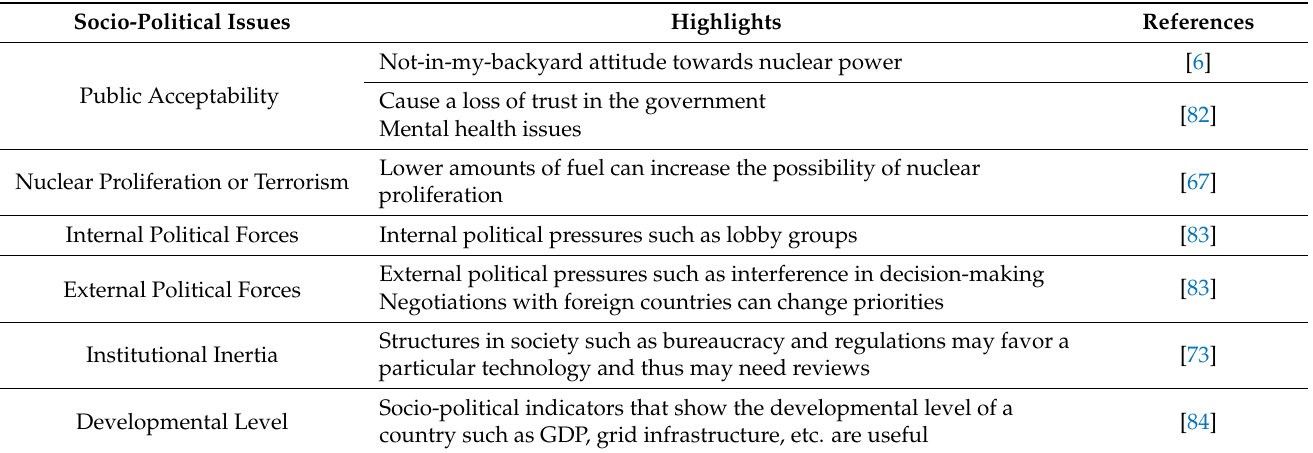
Table 6. Summary of socio-political issues.